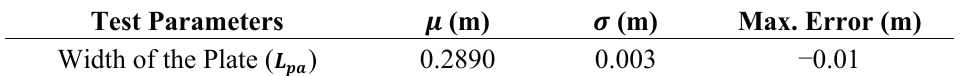
Table 2. Mean value and errors of measured width of the plate from the laser scanner. Test Parameters